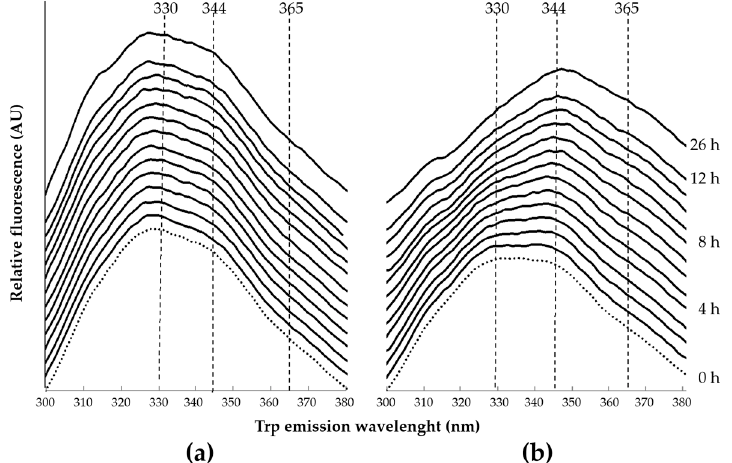
Figure 1. Trp fluorescence emission spectra of HDL of a representative healthy subject. The fluorescence intensity of HDL without urea ( a ) and with 8M urea ( b ) are shown. Spectra were recorded every hour using 30 μ g/mL of HDL protein concentration, normalized, and depicted chronologically from the bottom to the top. The wavelengths considered to estimate the denaturation of HDL ‐ apolipoproteins are indicated by the vertical dotted lines. The excitation wavelength was set at 280 nm. AU, arbitrary units.